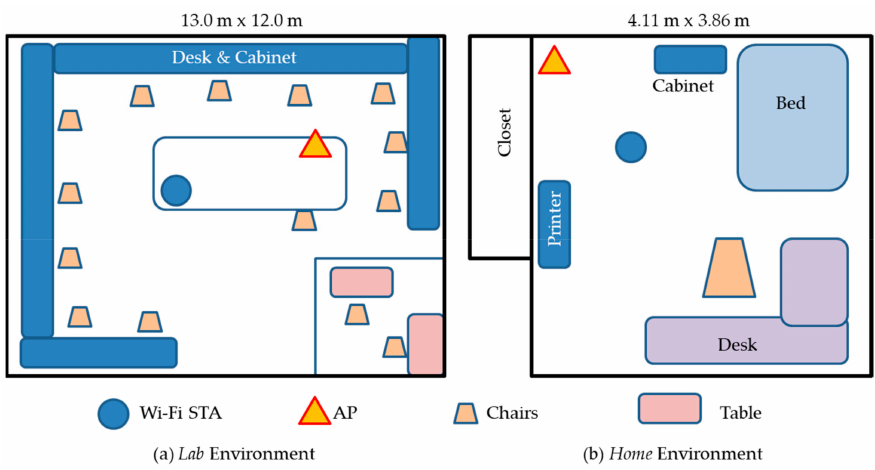
Figure 6. Schematic representation of testing environments as reported in SignFi